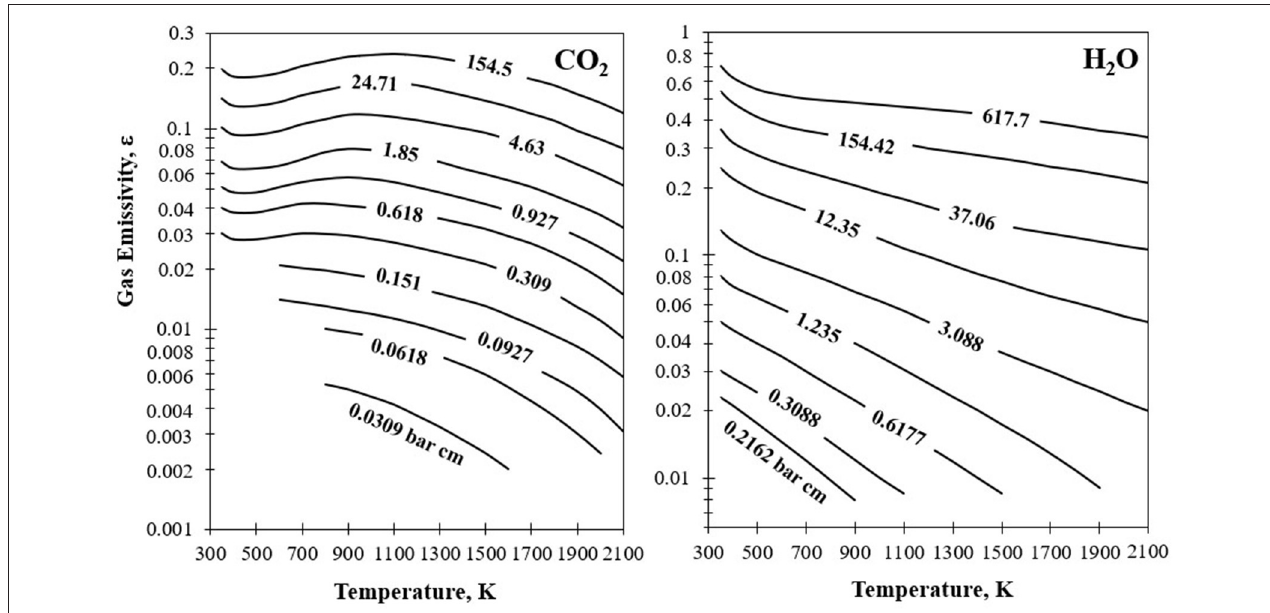
FIGURE 1 | Total emissivity of pure carbon dioxide (left) and pure water vapor (right) as a function of temperature (Hottel and Cohen, 1958) and modified by Alberti et al. (2015)